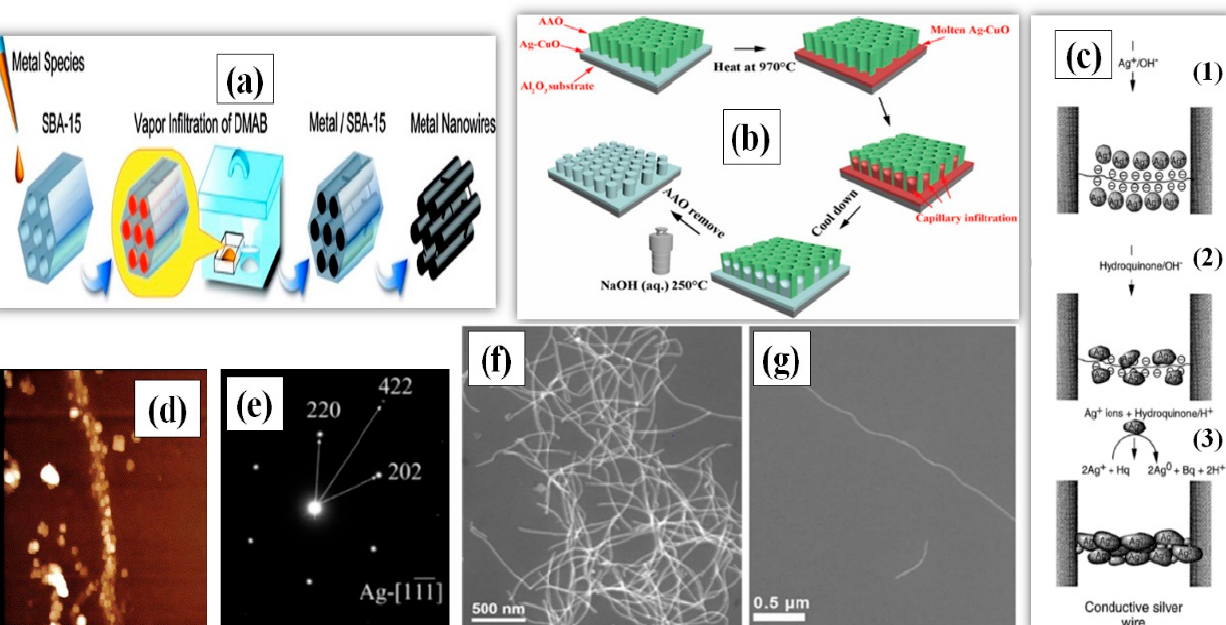
Figure 2. ( a ) A Schematic procedure for AgNW synthesis using Mesoporous Silica (SBA-15) through Vapor